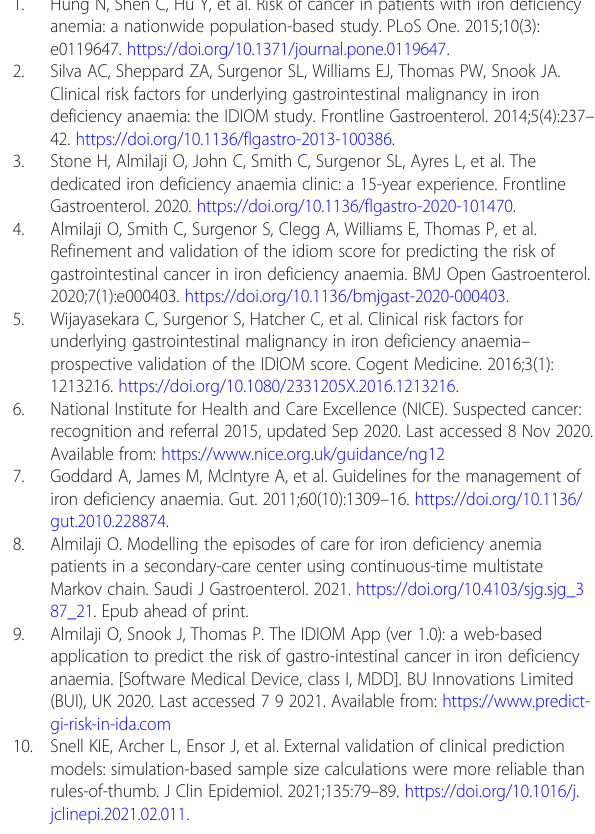
curve in Oxford dataset shows the relation between the estimated risks (on the x-axis) and the observed proportion of events (on the y-axis). Fig- ure S7. Flexible calibration curve in Sheffield dataset shows the relation between the estimated risks (on the x-axis) and the observed proportion of events (on the y-axis). Figure S8. Decision curve analysis for GI investi- gation using Oxford dataset. Grey line: penalised IDIOM model. Black line: “ investigate no-one ” strategy. Dashed line: “ investigate all ” strategy. The vertical axis displays standardized net benefit. The horizontal axis shows the risk thresholds. Figure S9. Decision curve analysis for GI investigation using Sheffield dataset. Grey line: penalised IDIOM model. Black line: “ in- vestigate no-one ” strategy. Dashed line: “ investigate all ” strategy. The ver- tical axis displays standardized net benefit. The horizontal axis shows the risk thresholds. Figure S10. Clinical impact curve for penalised IDIOM risk model using Dorset data, with 95% CIs constructed via bootstrapping. Of 1,000 patients, the heavy black solid line shows the total number who would be deemed low risk for each risk threshold. The blue dashed line shows how many of those would be true negatives. The vertical axis dis- plays standardised net benefit. The two horizontal axes show the corres- pondence between risk threshold and cost:benefit ratio. Figure S11. Clinical impact curve for penalised IDIOM risk model using combined val- idation data from Oxford and Sheffield, with 95% CIs constructed via bootstrapping. Of 1,000 patients, the heavy black solid line shows the total number who would be deemed low risk for each risk threshold. The blue dashed line shows how many of those would be true negatives. The vertical axis displays standardised net benefit. The two horizontal axes show the correspondence between risk threshold and cost:benefit ratio. Figure S12. Clinical impact curve for penalised IDIOM risk model using the Oxford dataset, with 95% CIs constructed via bootstrapping. Of 1,000 patients, the heavy black solid line shows the total number who would be deemed low risk for each risk threshold. The blue dashed line shows how many of those would be true negatives. The vertical axis dis- plays standardised net benefit. The two horizontal axes show the corres- pondence between risk threshold and cost:benefit ratio. Figure S13. Clinical impact curve for penalised IDIOM risk model using the Sheffield dataset, with 95% CIs constructed via bootstrapping. Of 1,000 patients, the heavy black solid line shows the total number who would be deemed low risk for each risk threshold. The blue dashed line shows how many of those would be true negatives. The vertical axis displays standar- dised net benefit. The two horizontal axes show the correspondence be- tween risk threshold and cost:benefit